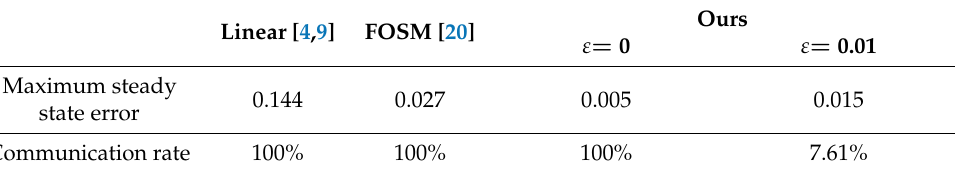
Table 1. Comparison of numerical results for different protocols. Our proposal reduces the estimation error with respect to linear and FOSM protocols in the full communication case. Moreover, adding event-triggered communication to our proposal produces a significant reduction in communication, while still achieving better error values than other